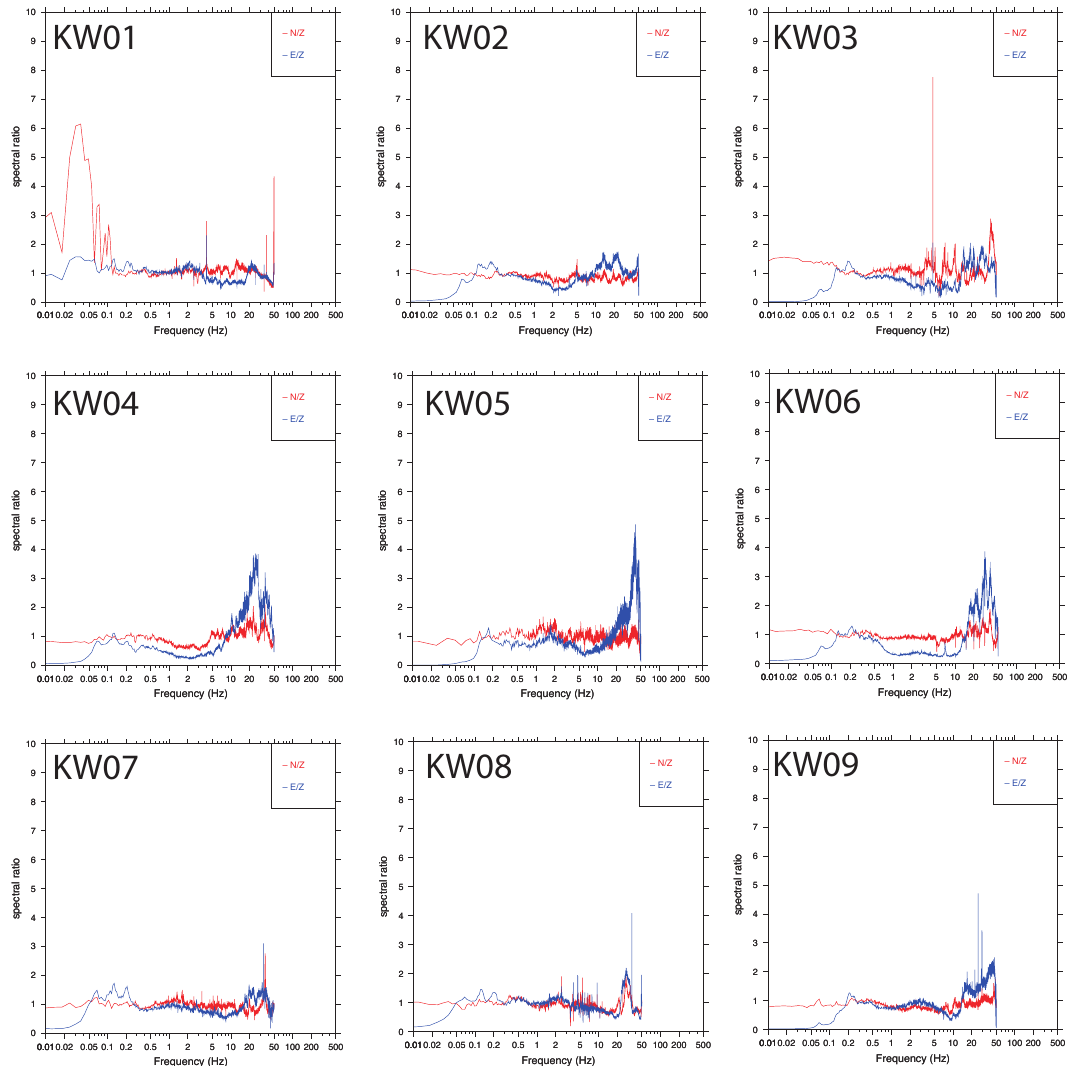
Figure 5. Spectral amplitude ratio of the two horizontal components ( E and N ) vs. the vertical component ( Z ), modified after Naka- mura